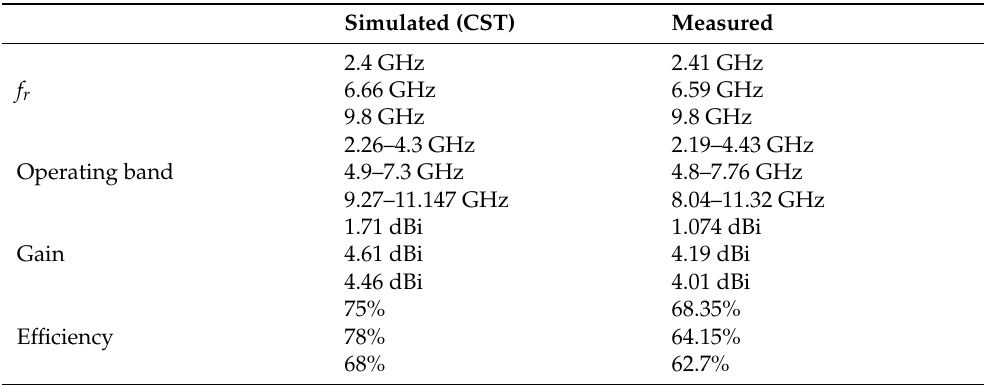
Table 3. Summary of simulation and experimental results for the designed Sierpinski hexagonal- shaped fractal